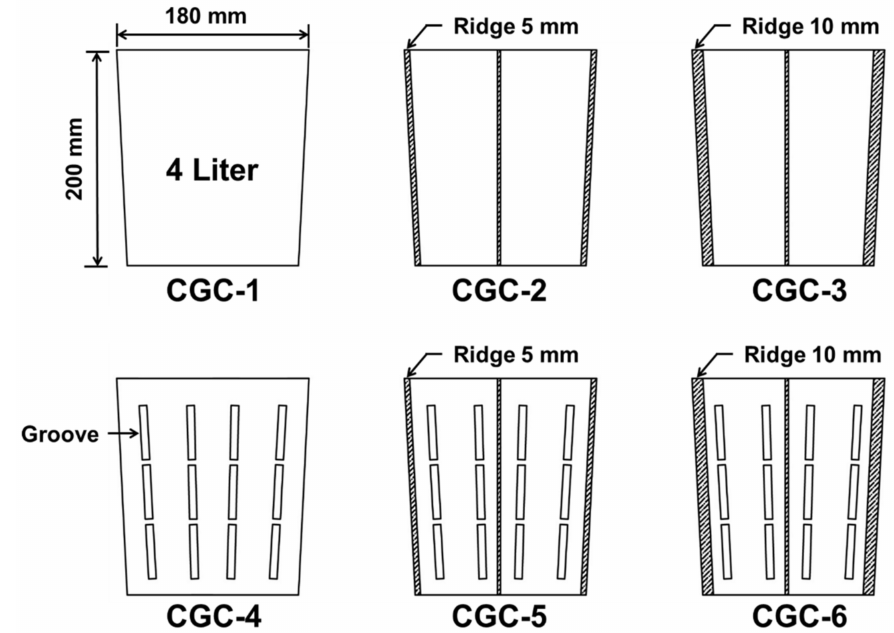
Figure 1. Six di ff erent container growth conditions (CGCs) used in this study. CGC-1: Control container without modification; CGC-2: CGC-1 with inside 5 mm thick root-turning bump; CGC-3: CGC-1 with inside 10 mm thick root-turning bump; CGC-4: negative phototropism container with a vertical striped slit was made on the surface of CGC-1; CGC-5: CGC-4 with inside 5 mm thick root-turning bump; CGC-6: CGC-5 with inside 10 mm thick root-turning